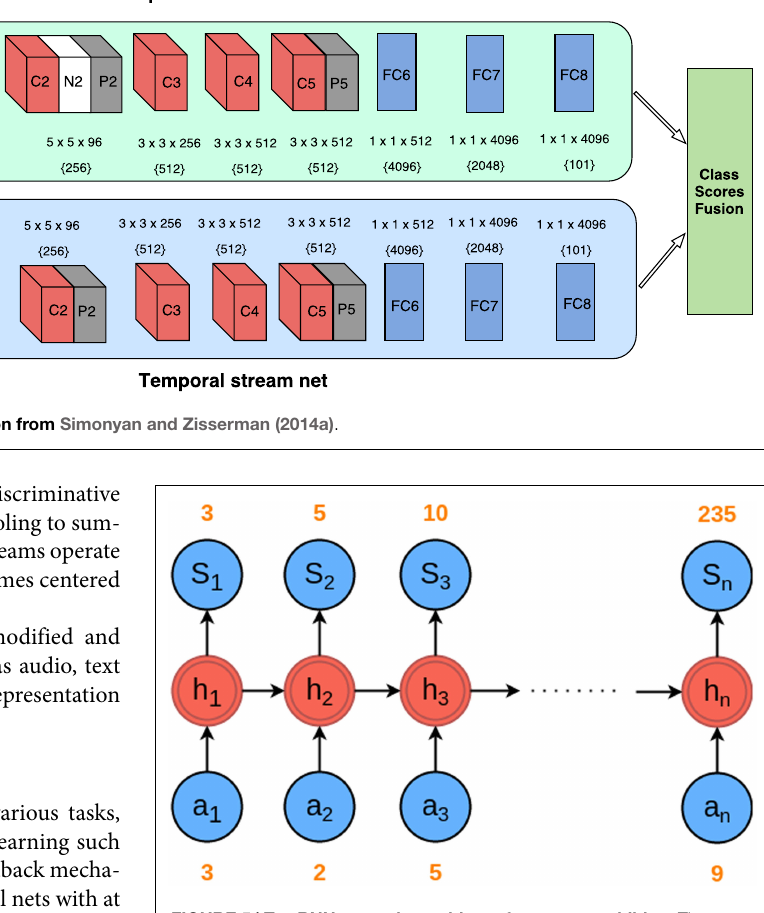
FIGURE 5 | Toy RNN example: problem of sequence addition . The inputs and outputs are shown in blue. The red cells correspond to the hidden units. An unrolled version of the RNN is